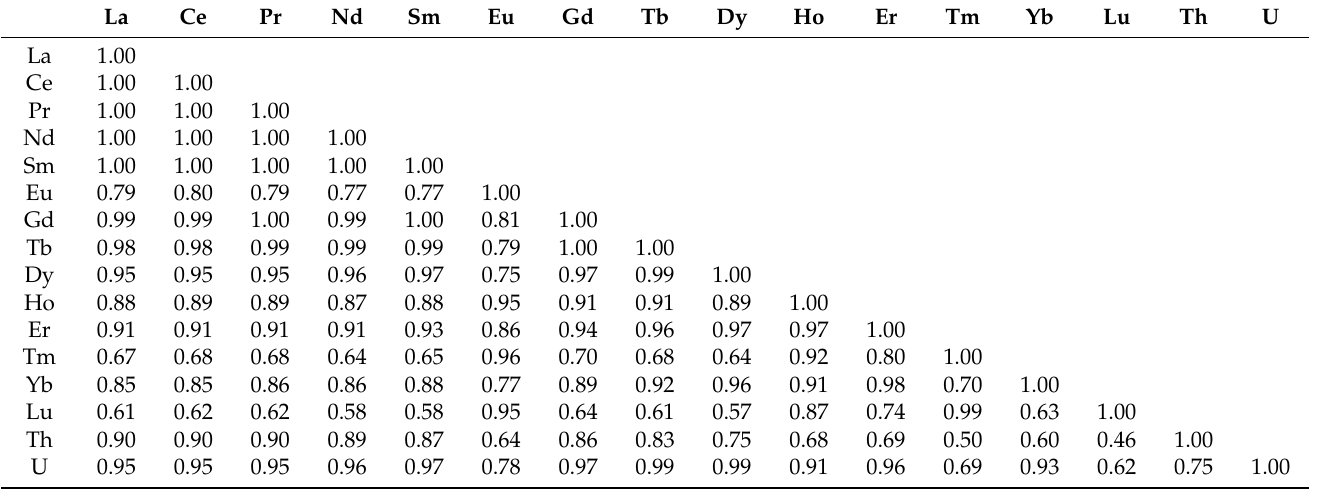
Table 6. Pearson correlation coefficient of Th, U and REEs in soils ( n =